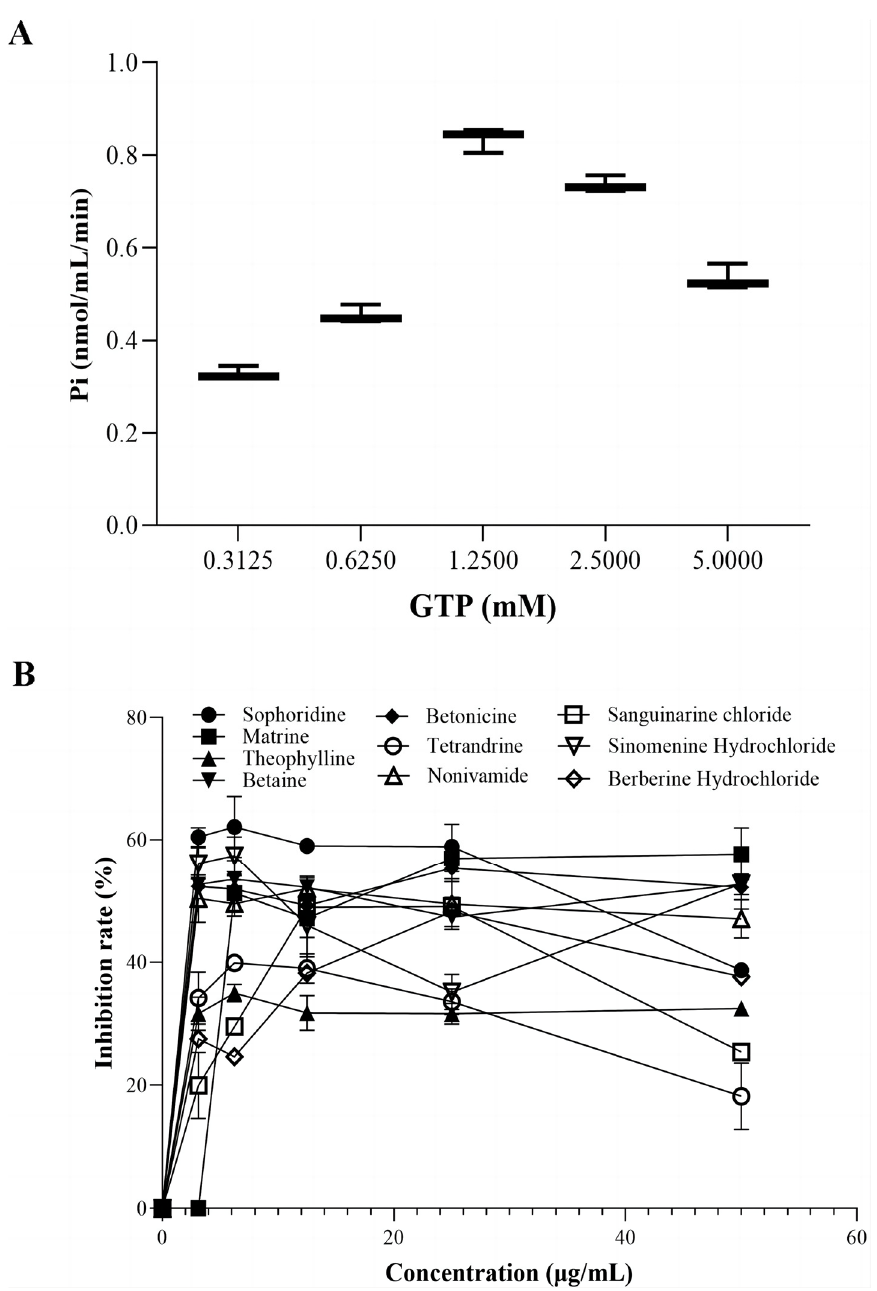
Figure 3. GTPase activity of the recombinant FtsZ protein and its inhibitors. ( A ) Determination of GTPase activity of the recombinant FtsZ protein. ( B ) E ff ects of 10 alkaloids on GTPase activity.